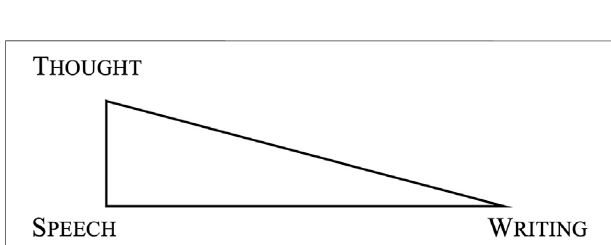
FIGURE 5 | Thought, Speech, Writing according our